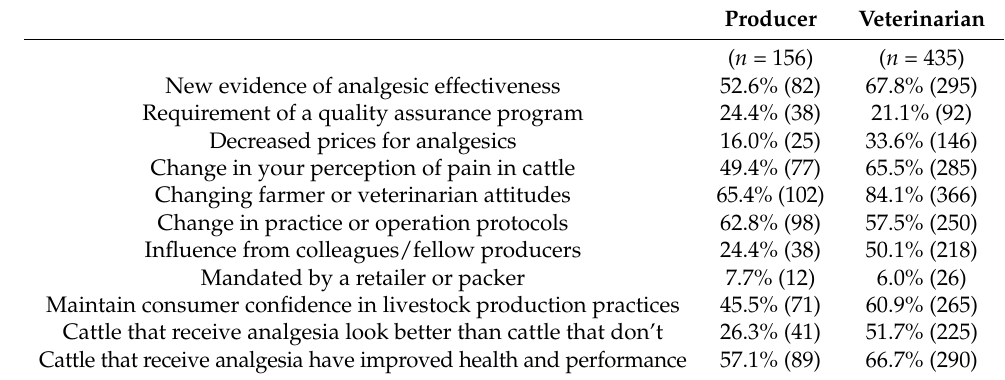
Table 3. Survey respondent ( n = 591) reasons for increased analgesic use in the last 10 years based on role